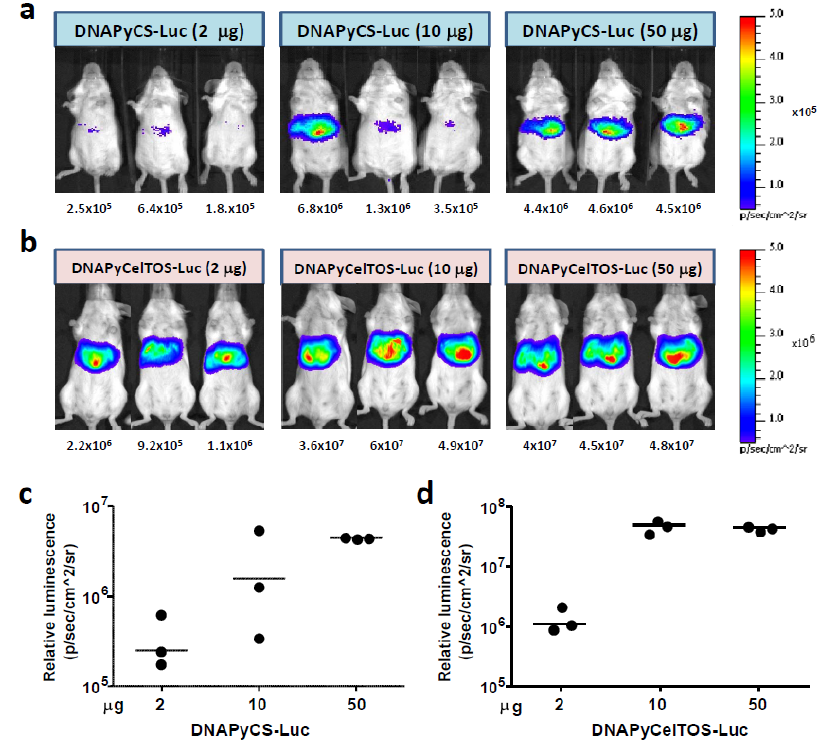
Figure 2. Luciferase expression in the liver after Hydrodynamic tail vein (HTV) injection of various doses of each plasmid DNA, co-encoding genes for a malaria antigen and luciferase. ( a ) and ( b ) Non-invasive bioluminescence imaging depicts the luciferase expression in the liver after HTV injection of 2, 10, and 50 μ g of plasmid DNA co-encoding genes for PyCS antigen and luciferase in ( a ) and plasmid DNA encoding genes for PyCelTOS antigen and luciferase in ( b ). Three day after HTV injection, mice were anesthetized and injected